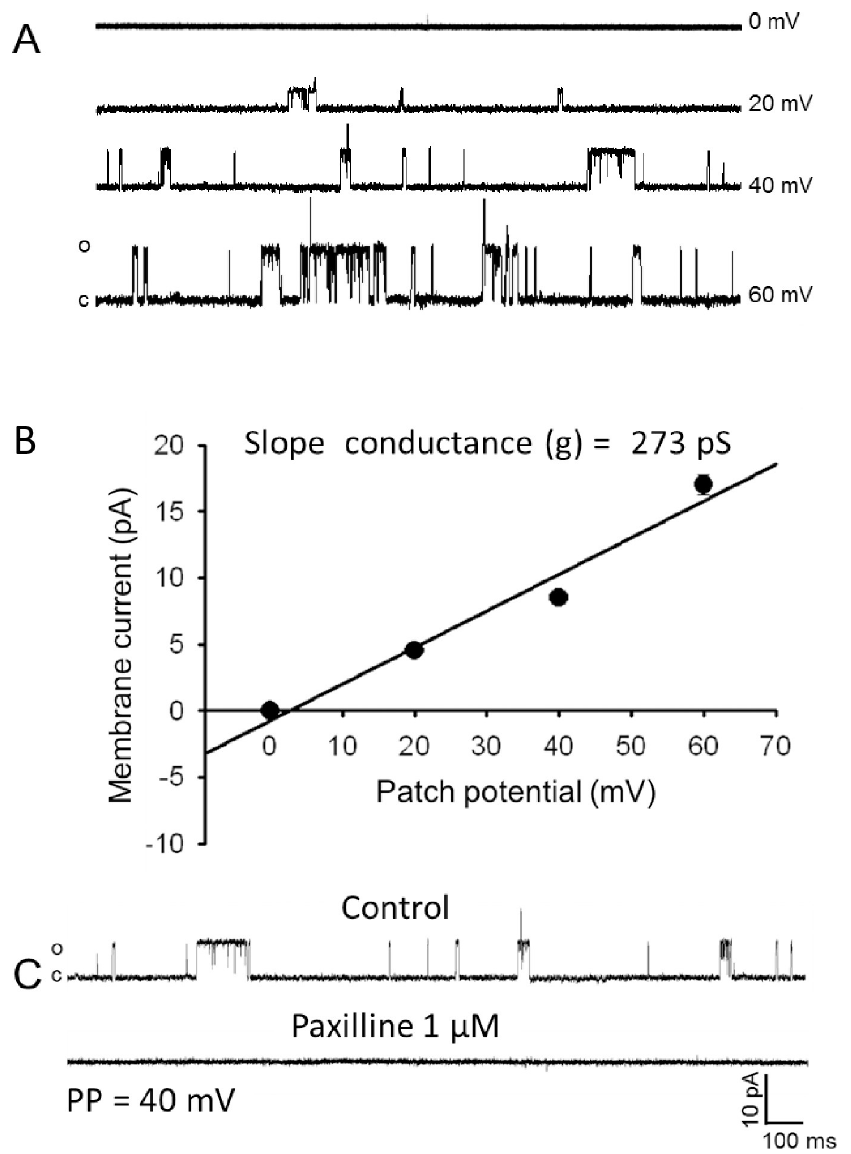
Fig 3. Femoral smooth muscle cells express an active BK Ca channel. Excised inside-out membrane patches of isolated mice femoral arterial smooth muscle cells express a voltage-dependent openings of single-channel K + current (A) with a unitary slope conductance of 273 pS (B) and is sensitive to inhibition by the specific BK Ca channel current inhibitor Paxilline (C).